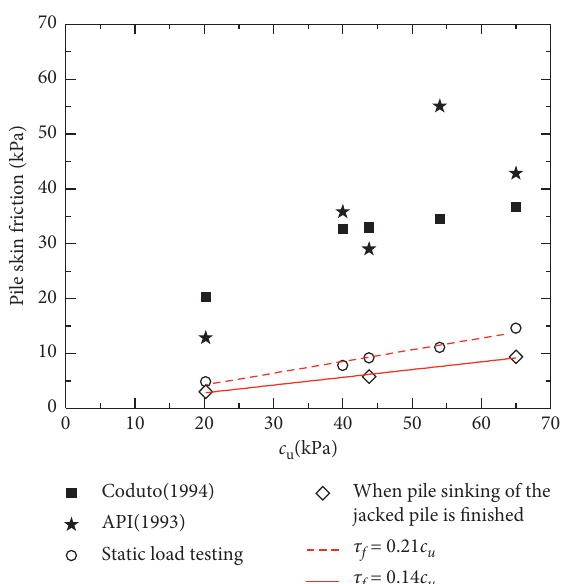
Figure 20: Pile skin friction versus undrained shear strength of the soil.